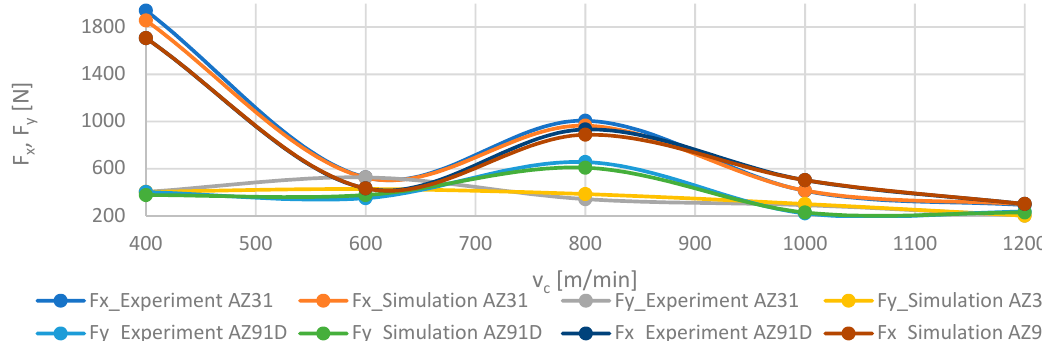
Figure 14. Comparison of experimental and numerical results depending on the cutting speed v c for trochoidal step s tr = 15% for F x and F y components of the cutting force in milling of AZ31 and AZ91D alloys.